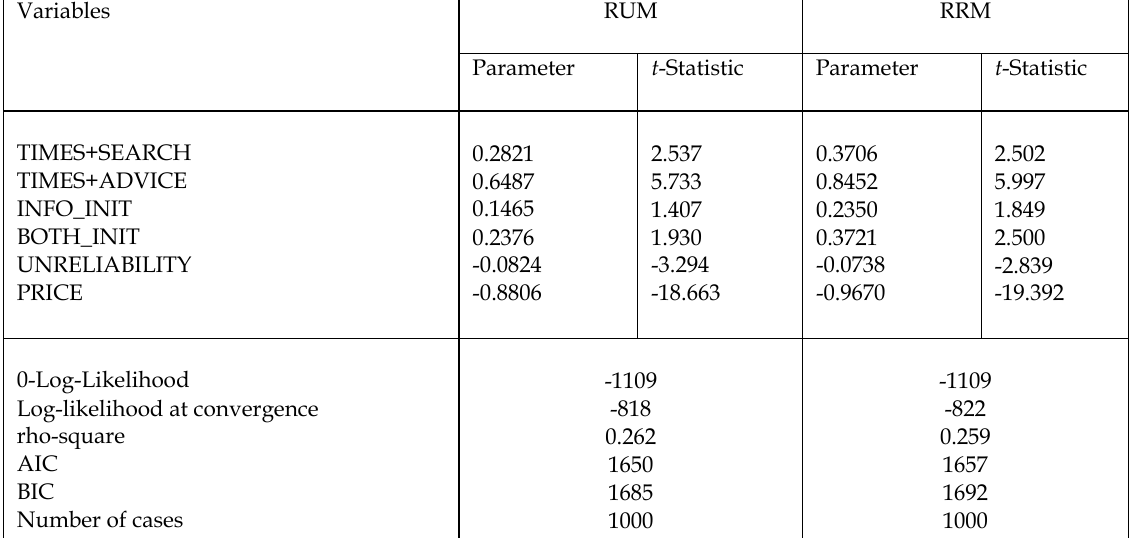
Table 2 . Travel information acquisition choices (estimation results)